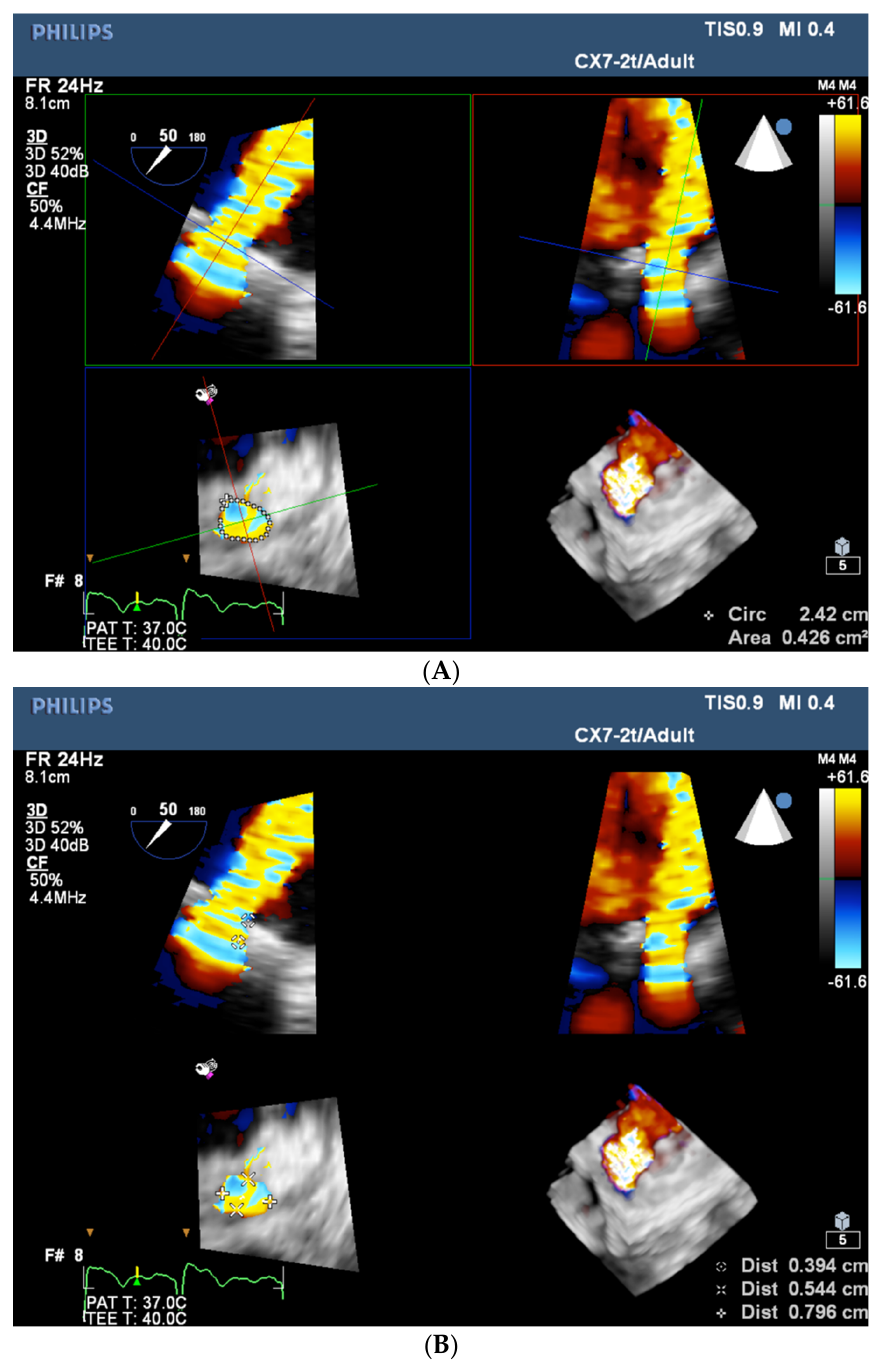
Figure 1. ( A ) RT-3D TOE multi-planar visualization of PVL’s vena contracta—measurement of its area (left lower panel). ( B ) RT-3D TOE multi-planar visualization of PVL’s vena contracta—measurement of its length (left upper panel) along with minimal and maximal extent (left lower panel).